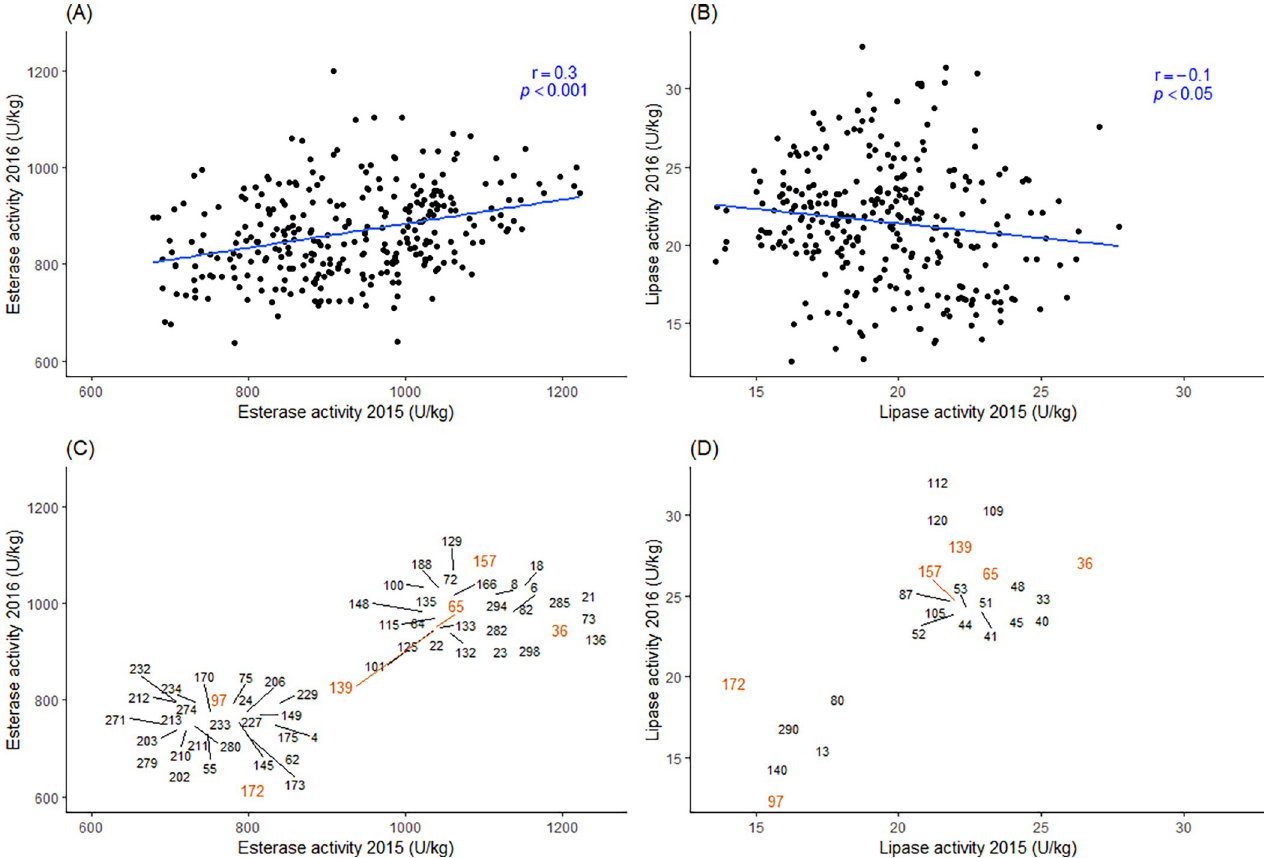
Fig 1. Esterase (A) and lipase (B) activities of 300 wheat cultivars grown in 2015 and 2016. Each dot and number represent one wheat cultivar. Linear regression model of esterase activity from the two years is represented by the blue line. Cultivars with their esterase (C) and lipase (D) activities in the upper and lower quantiles in both years. Cultivars overlapped in (C) and (D) were labeled in